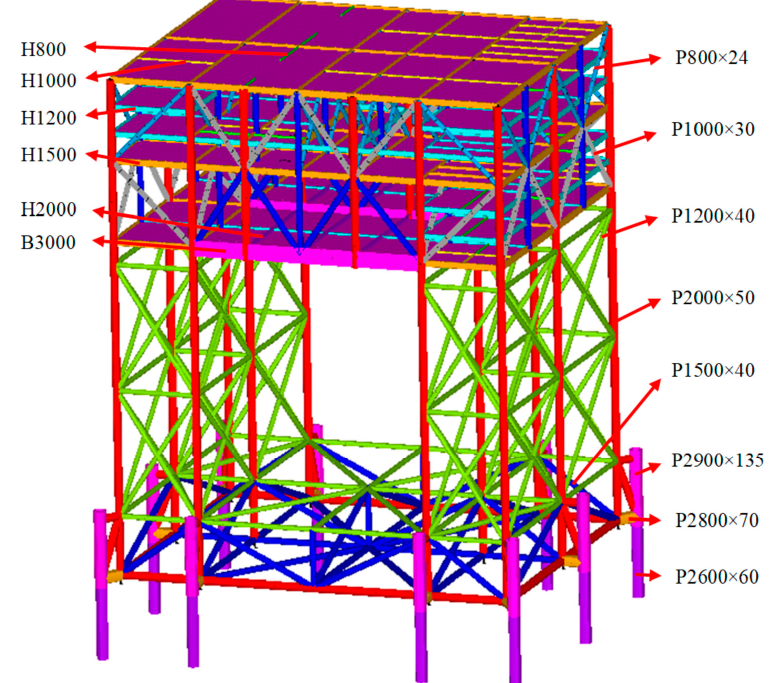
Figure 1. Schematic diagram of the electrical platform.